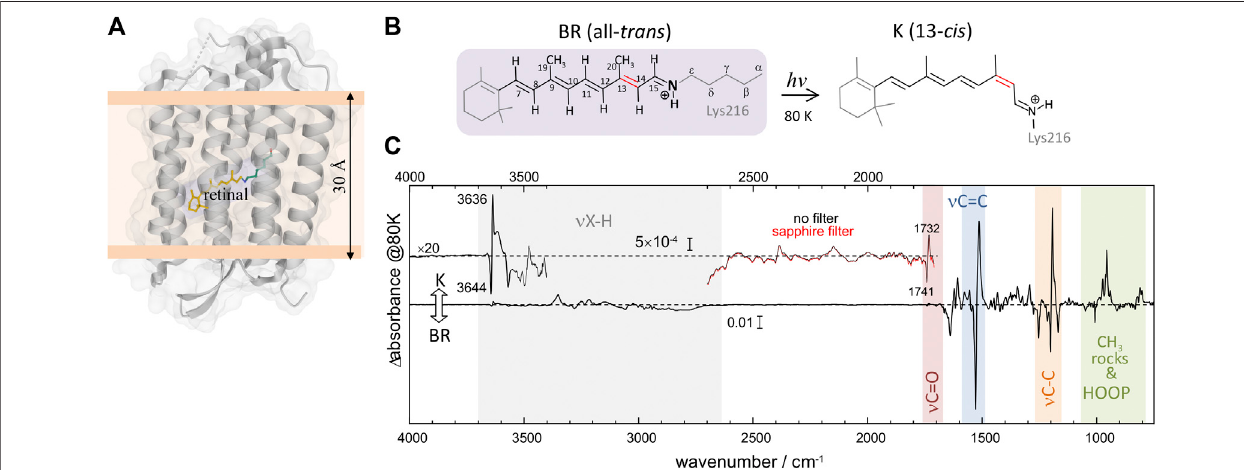
FIGURE 1 | Structural and vibrational differences between bacteriorhodopsin (BR) in its initial state (all- trans retinal) and in the K intermediate (13- cis retinal). (A) StructureofBRintheinitialstate(pdb1C3W)(Lueckeetal.,1999),highlightingthelocationoftheretinalchromophore(inyellow),formingaprotonatedSchiffbase(PSB) withLys216. (B) Schematicrepresentation ofthe PSBretinalchromophore intheinitial stateofBR(all- trans , 15-anticonformation) and intheKintermediate(13- cis ,15- anticonformation),including thenumbering ofrelevantcarbon atoms. (C) K-minus-BRdifference FT-IRspectrumobtained byillumination at 80 K,withhighlighted regions corresponding to X-H stretches, carboxylic C (cid:1) O stretches, retinal C (cid:1) C and C-C stretches, retinal CH 3 rocks, and retinal hydrogen out of plane (HOOP) ethyl wags. The inset above 3,400 cm − 1 , besides illustrating the noise level, shows bands at 3,644 ( – ) and 3,636 (+) cm − 1 from the ν O-H of internal dangling water 401. The insetbetween 2,600 and 1,710 cm − 1 shows bands at 1732 (+) and 1741 ( – ) cm − 1 from carboxylic ν C (cid:1) O vibrations of Asp115, as well as several bands never reported before. Measurements with a sapphire window, acting as a high pass fi lter (cutoff at ∼ 1,650 cm − 1 ), exclude that double-modulation artifacts might contribute to the absorption changes between 2,600 and 1,710 cm − 1